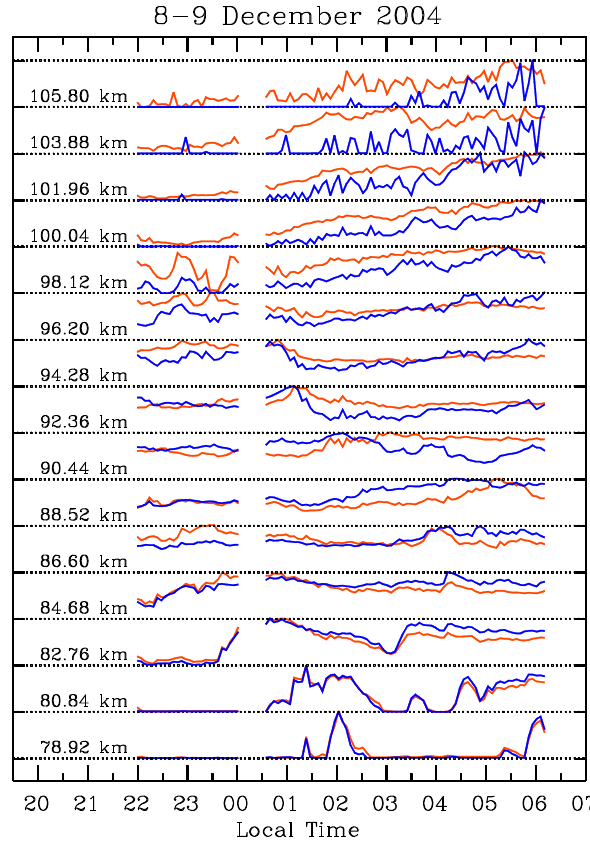
Fig. 8. Time variations of the relative densities for Na (orange line) and Fe (blue line) observed at altitudes between 78.92 and 105.80km (plotted in every 20 altitude bins) during the night of 8– 9 December 2004. Note that the temporal variations of the Na and Fe relative densities show an excellent similarity on the bottommost layer underside between 80.84 and 82.76km, particularly on small time scale.